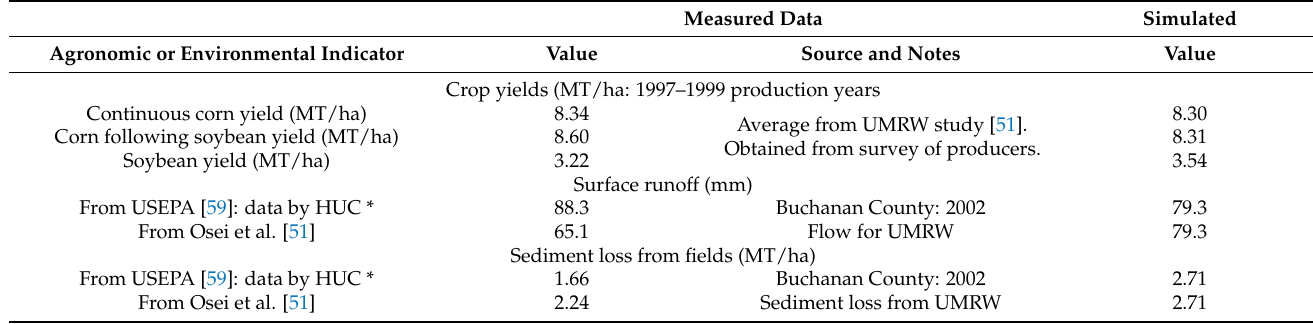
Table 5. APEX model validation results for 1998–2000 application in northeast